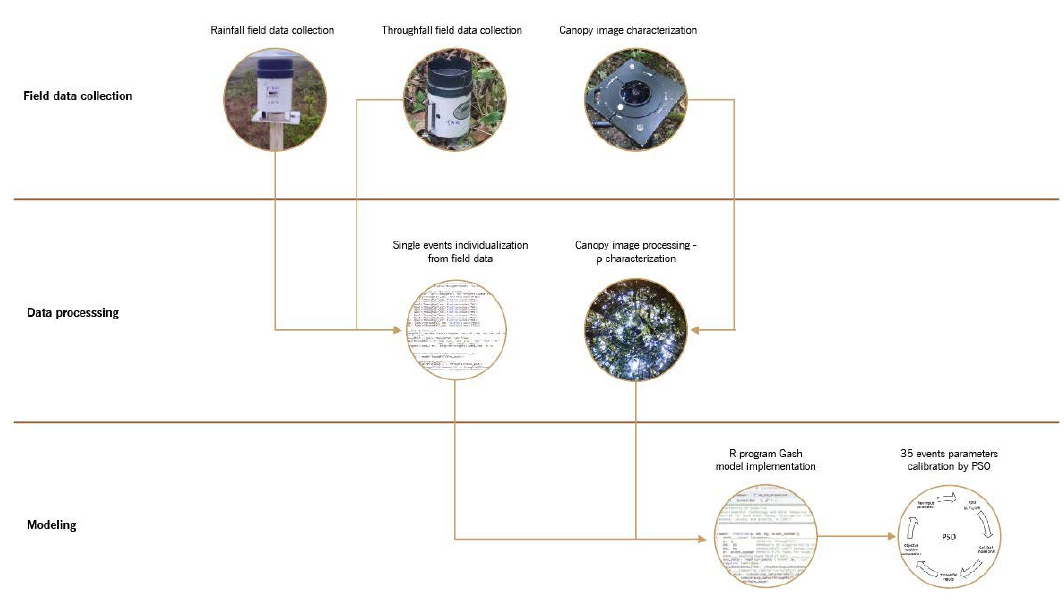
Figure 5. Methodological steps for numerical modeling.